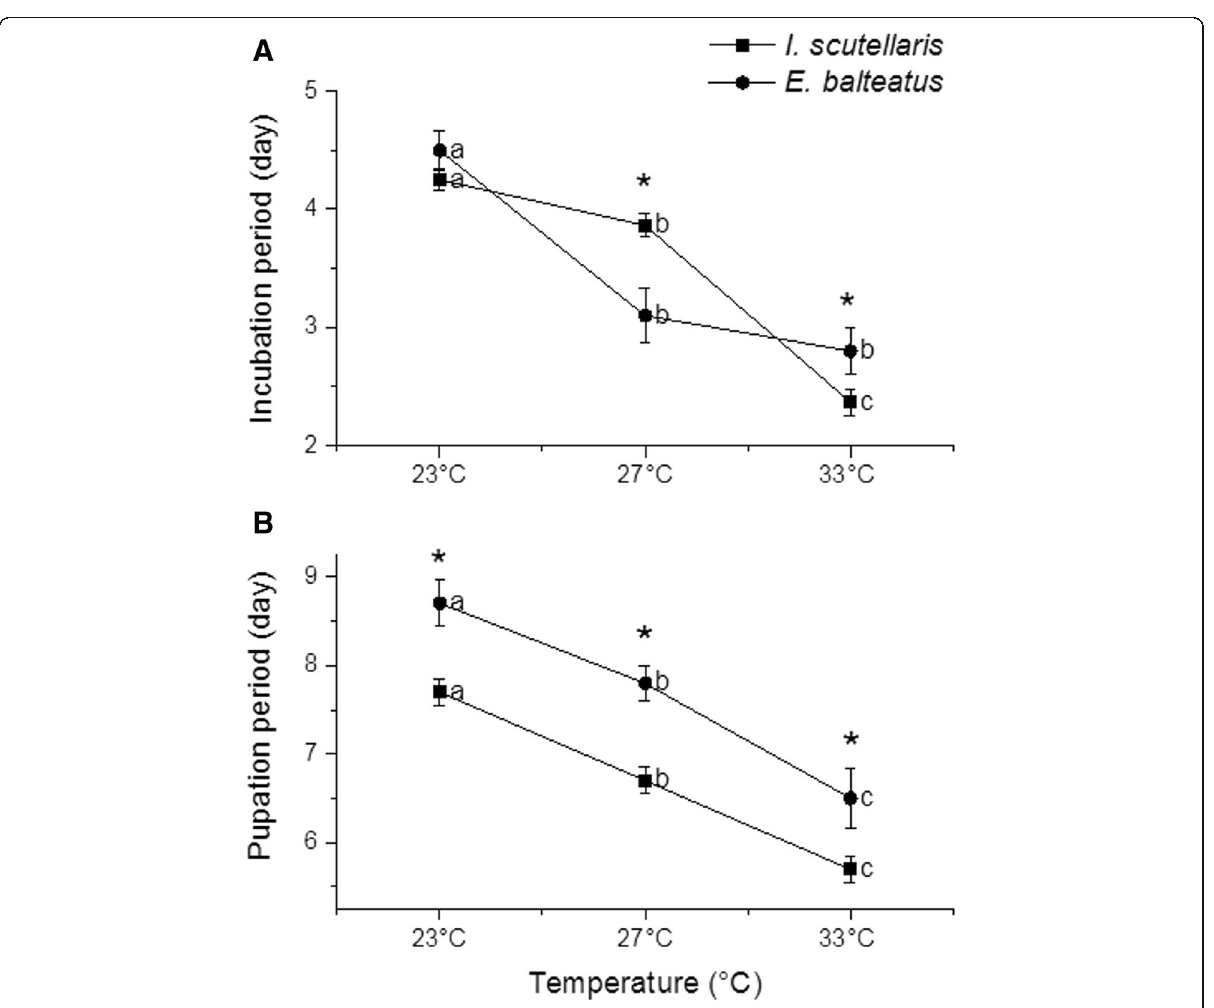
Fig. 1 Relative fitness of I. scutellaris and E. balteatus , under different temperature regimes, expressed in terms of egg incubation period ( a ) and pupation period ( b ). The data points presented are means± SEM. Different lowercase letters above each line demonstrate a significant difference among each data point, while an asterisk above a pair of data points presents a significant difference among two predator species ( P <